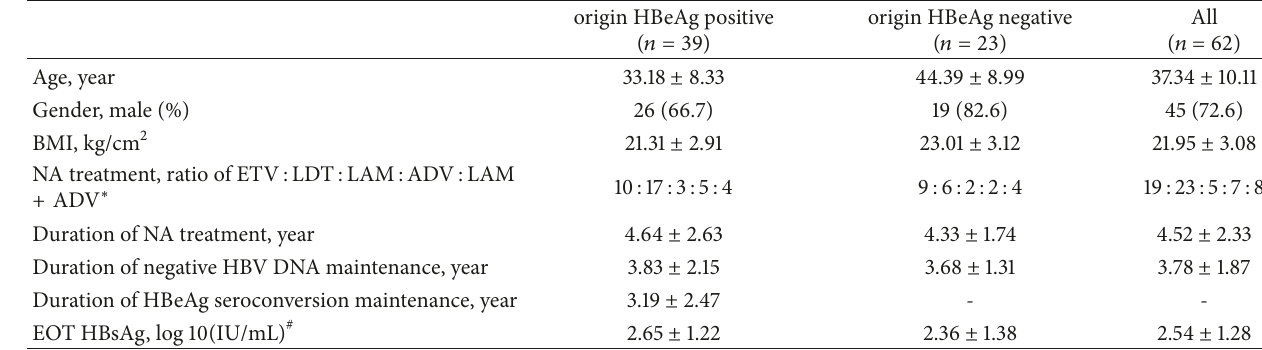
Table 1: Baseline characteristics of 62 patients before NA treatment